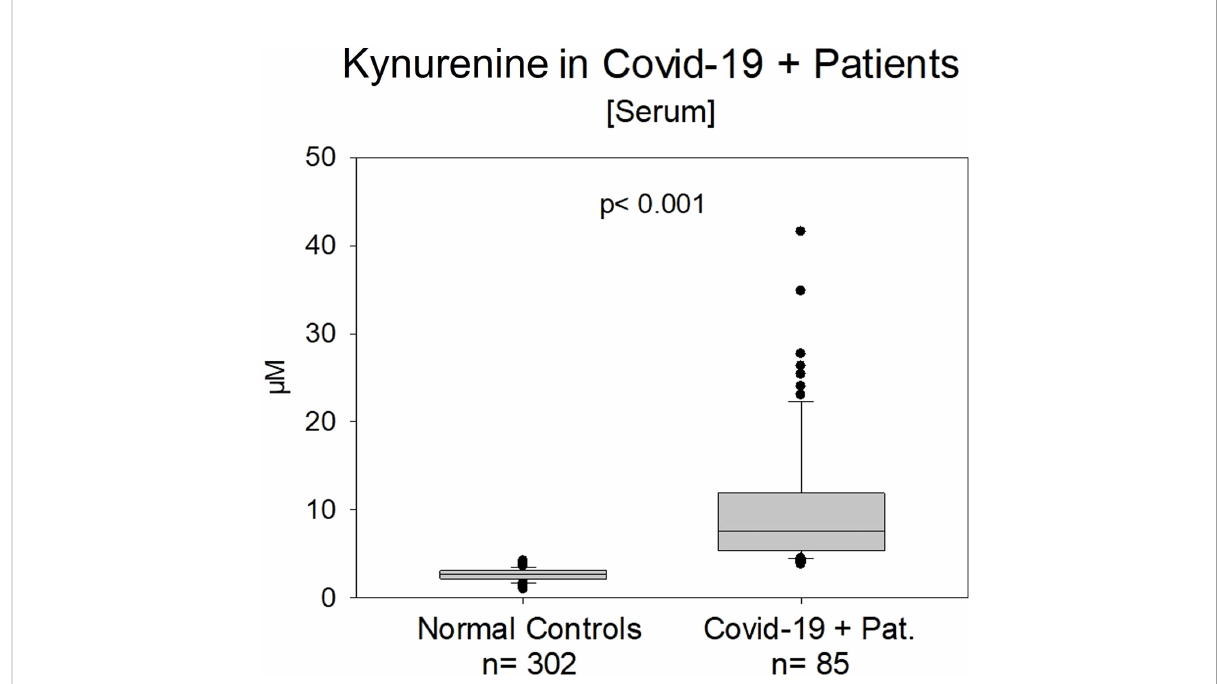
FIGURE 2 Kynurenine in normal controls (n=302) vs. COVID-19 patients in the early acute clinical state (n=85). The difference was signi fi cant (p< 0.001). We left out two results (58 and 43 µM) with an extreme hyperin fl ammatory syndrome in the COVID-19 positive group